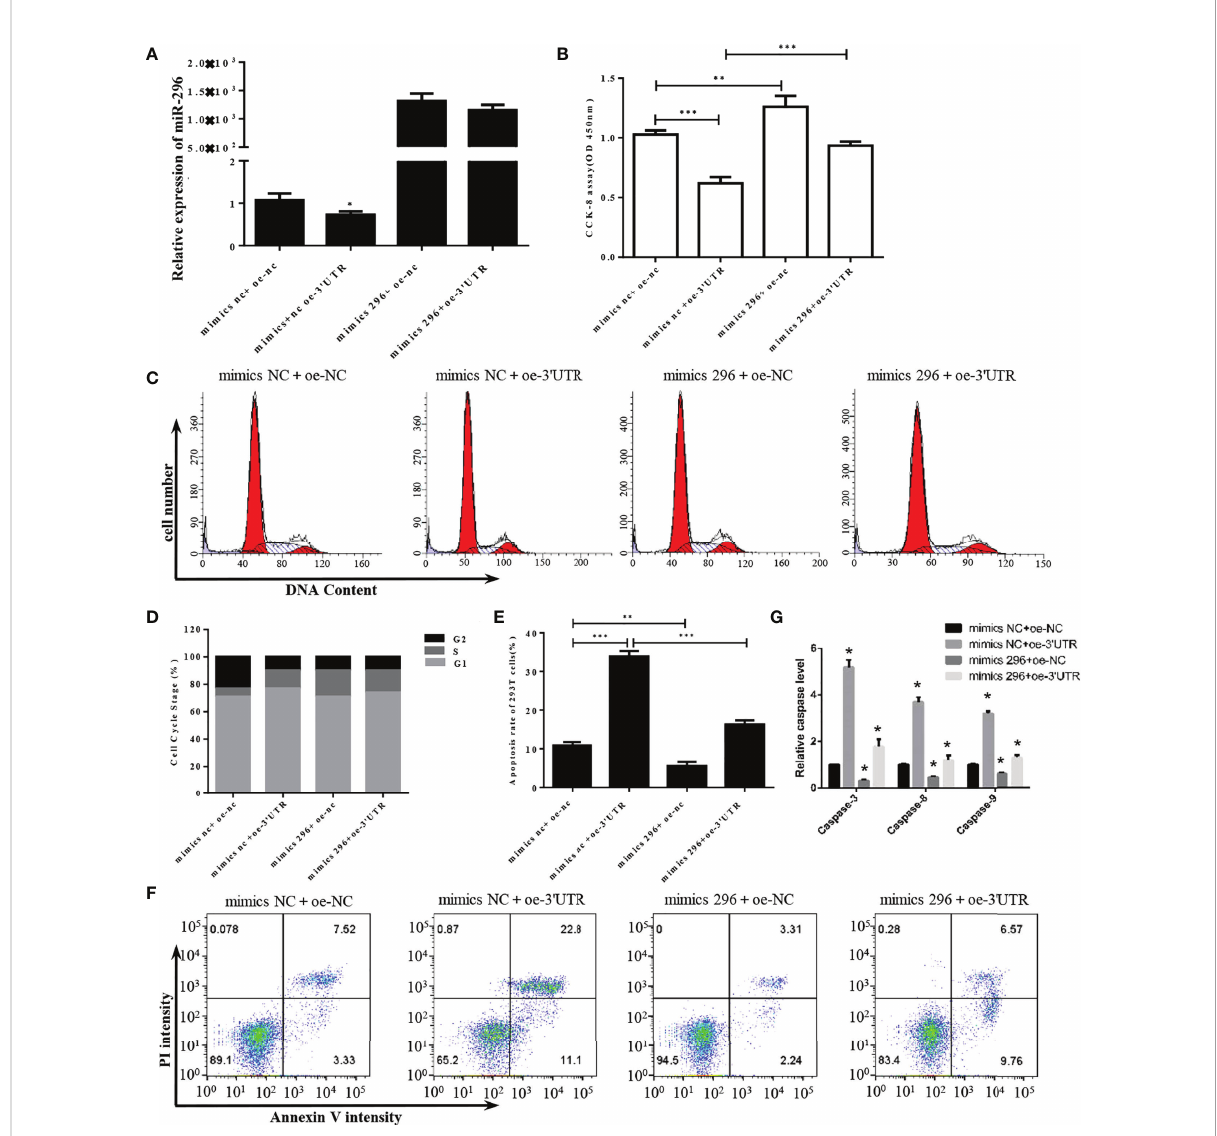
FIGURE 4 S-3 ′ UTR disturbed 293T cell growth though knock-down of miR-296. (A) Level of miR-296 expression in 293T cells. (B) Reduced 293T cell proliferation induced by overexpression of S-3 ′ UTR was partially recovered by miR-296 mimics. (C, D) Effects of S-3 ′ UTR on 293T cell cycle could not be recovered by miR-296 mimics. (E, F) Apoptosis of 293T cells induced by overexpression of S-3 ′ UTR was partially reduced by miR- 296 mimics. (G) caspase-3/8/9 assay to check apoptosis. (*p<0.05, **p<0.01,